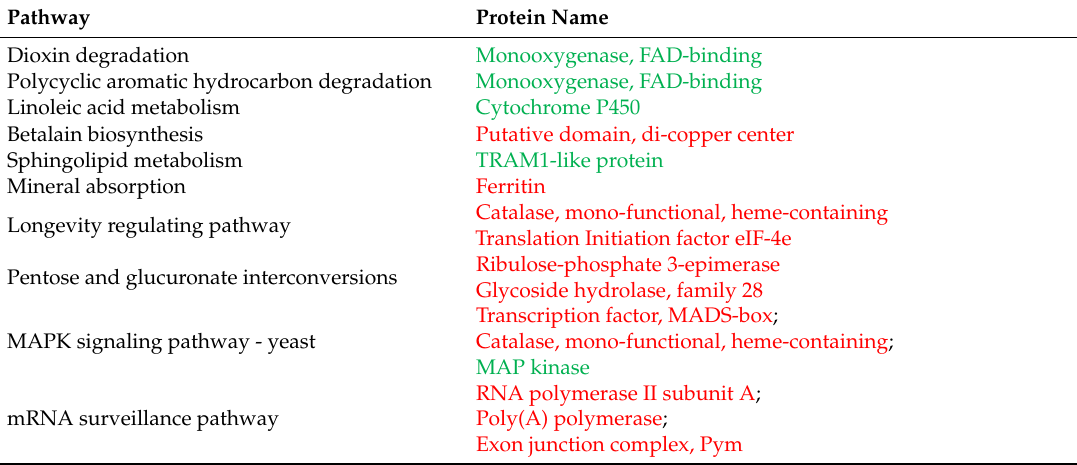
Table 4. Pathways encompassed by the DEPs 1